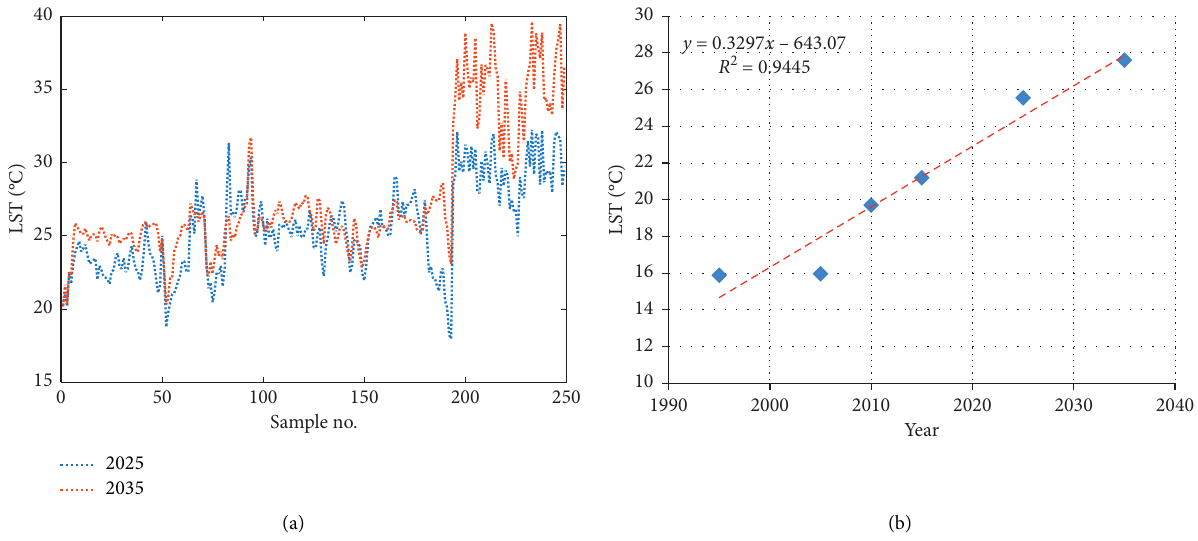
Figure 13: (a) 2025 and 2035 prediction LST using ANFIS model; (b) linear fitting of mean values for the